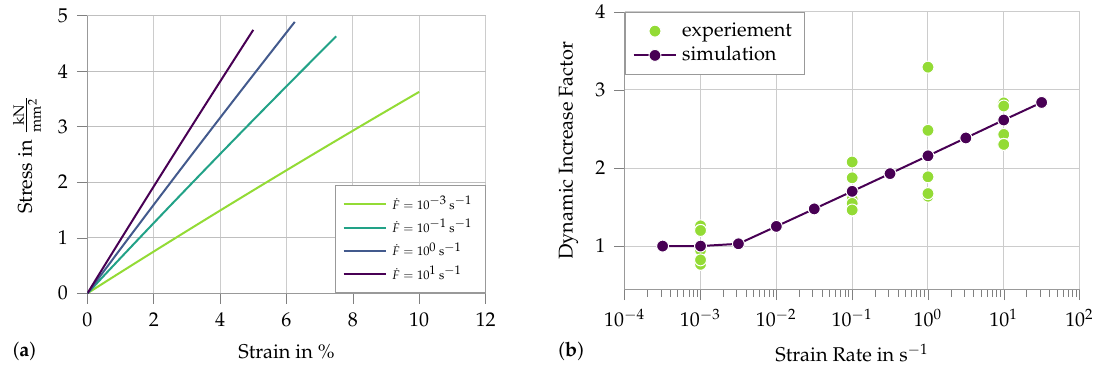
Figure 3. Simulation of single-fiber tension tests with rate-dependent material properties: ( a ) stress–strain diagram; and ( b ) the dynamic increase factor of the secant stiffness at fracture compared to experimental results from [5]. Material parameters used: E = 50kN/mm 2 , α I = 0.19 and α II = 1.8 × 10 − 3 .